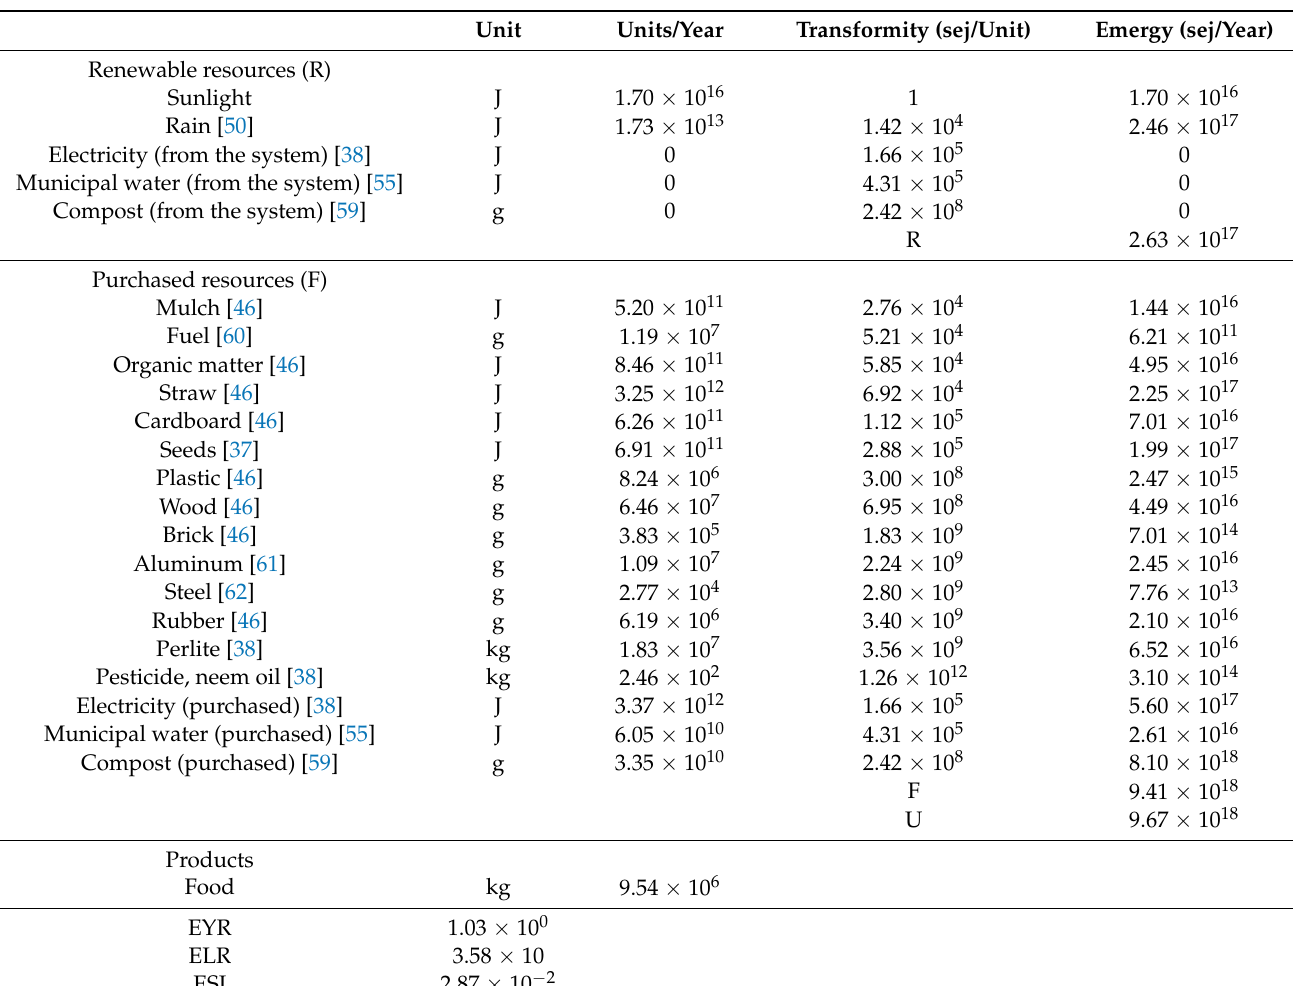
Table 7. Emergy calculation of urban farm (before). Unit Units/Year Transformity (sej/Unit) Emergy